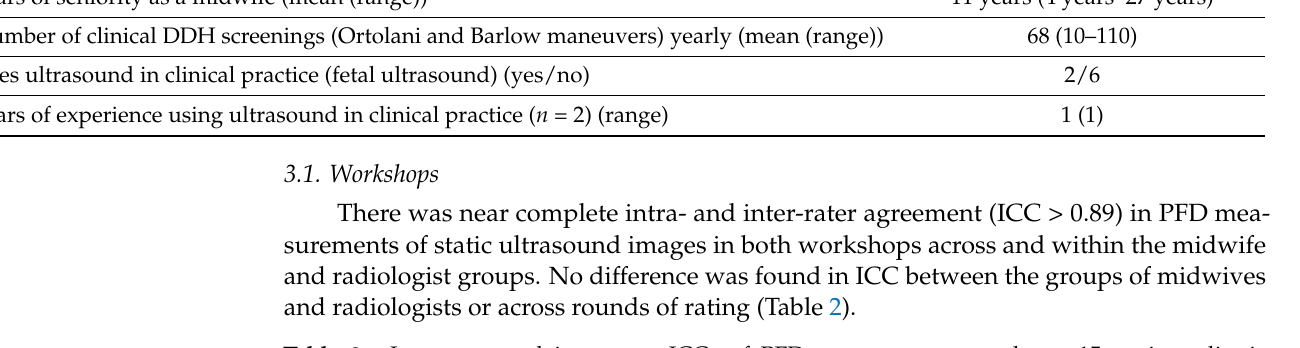
Table 2. Inter-rater and intra-rater ICCs of PFD measurements made on 15 static